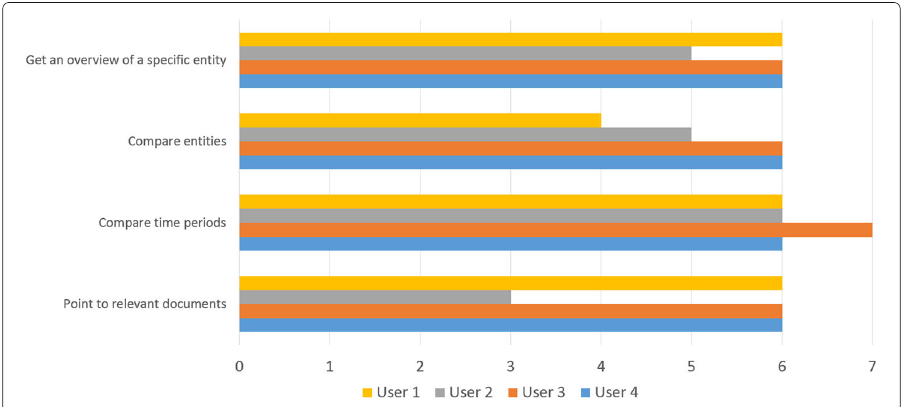
Fig. 4 Evaluation. User test questionnaire